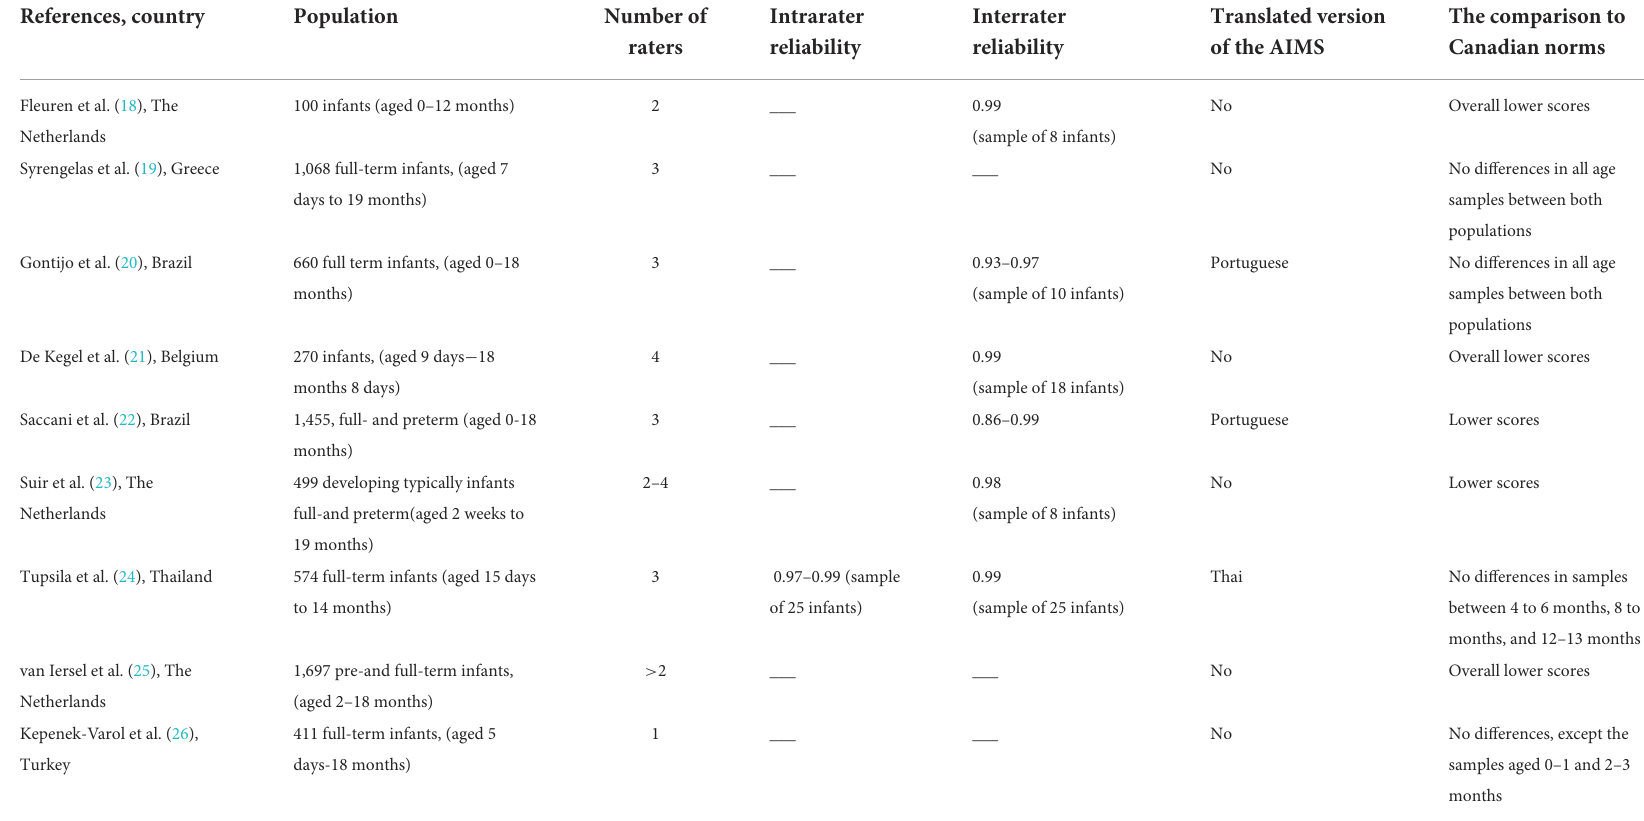
TABLE 2 The studies on the standardization of the AIMS in other populations than the